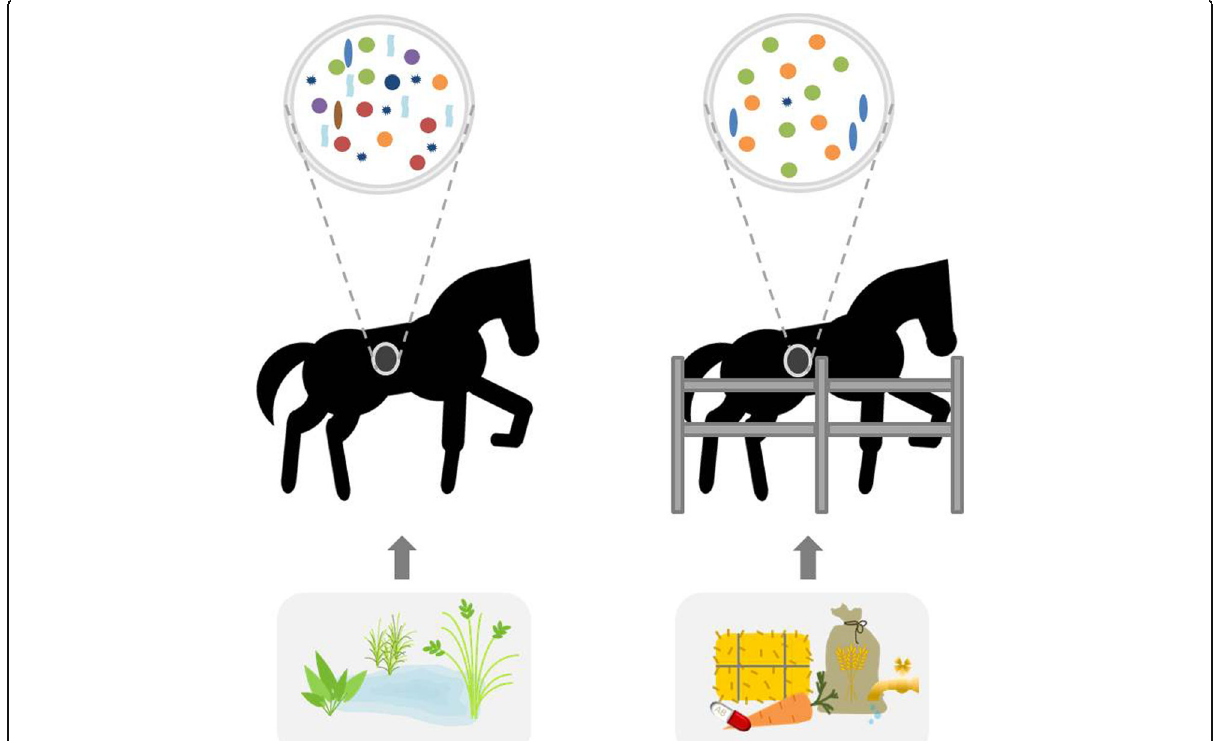
Fig. 2 The anthropogenic impact on horse microbiomes. Microbiomes of non-domesticated horses (left) include a more diverse spectrum of microbiota compared to those of domesticated horses (right). Beyond age, differences in housing and pasture habits [164], composition of feeding diets [165, 166], contact with humans, veterinary health care and medication seem to be among the most influencing factors for equine microbiomes [101]. Interestingly, similar observations are available for the humans, since indigenous populations seem to have a much broader spectrum of microbiota compared with industrialized countries